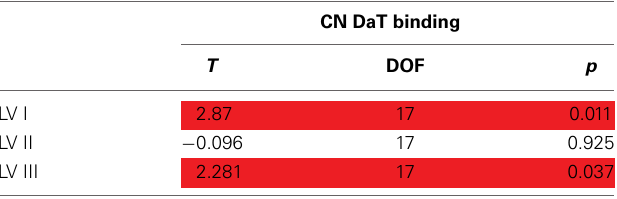
Table 3 | Latent variable scores and mean caudate DaT binding.